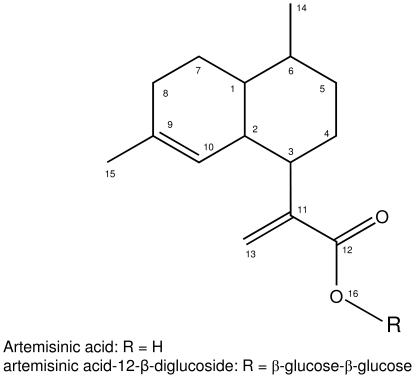
Structure of artemisinic acid (R  =  H) and artemisinic acid-12-β-diglucoside (R  =  β-glucose-β-glucose).Atom numbers are referred to in Table 2.